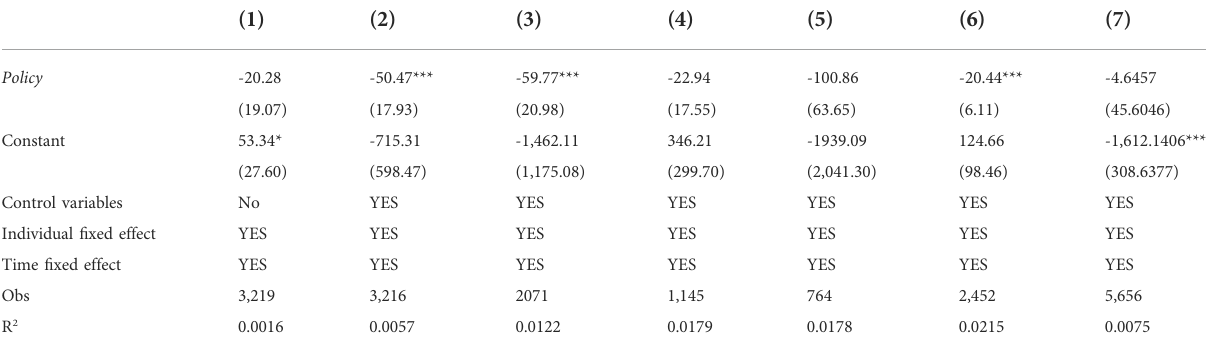
TABLE 5 Regression results for industrial pollutant